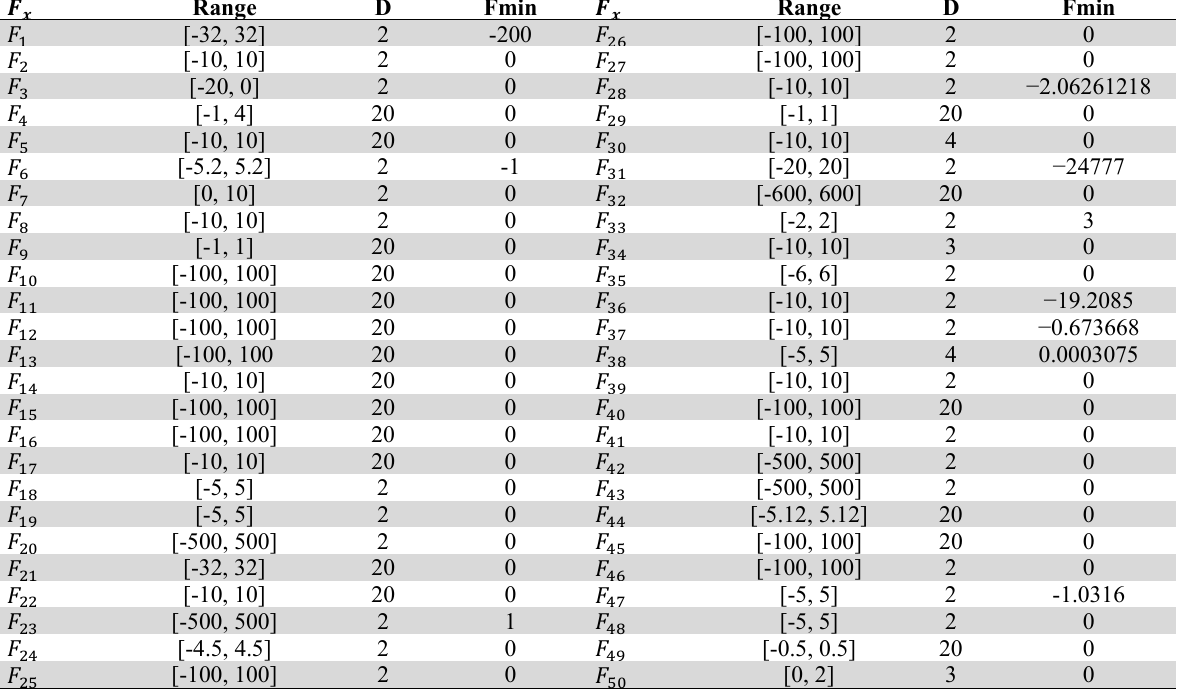
Bounds, dimensions and minimum